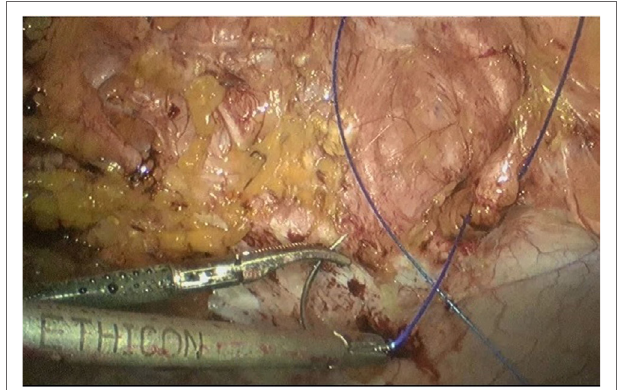
FIgURe 1 | Closure of the midline or linea alba through a continuous, self-sustaining, non-resorbable V-Lok 1./0